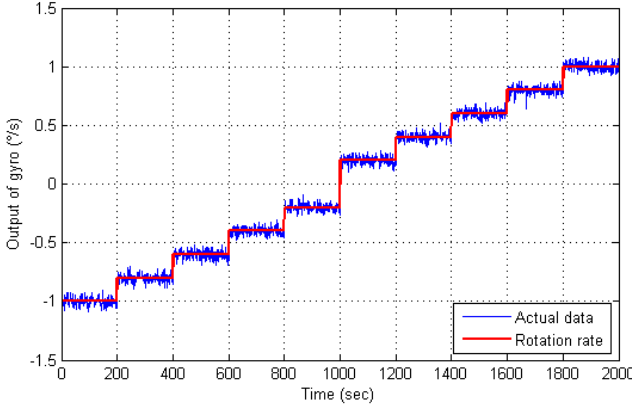
Figure 6. Rotation experimental results of a dual-mass MEMS gyroscope.